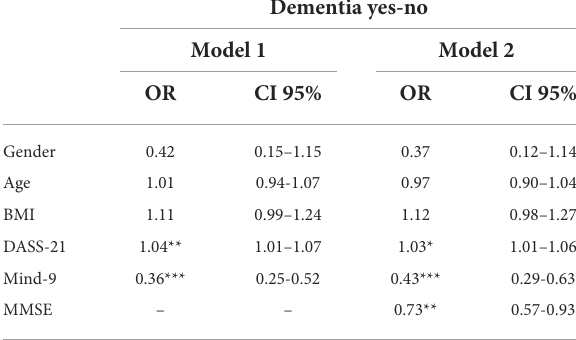
TABLE 4 Odds ratios (OR) and 95% confidence intervals (CI) from logistic regression analysis of absence of dementia as a function of MIND-9, gender, age, BMI DASS-21 and